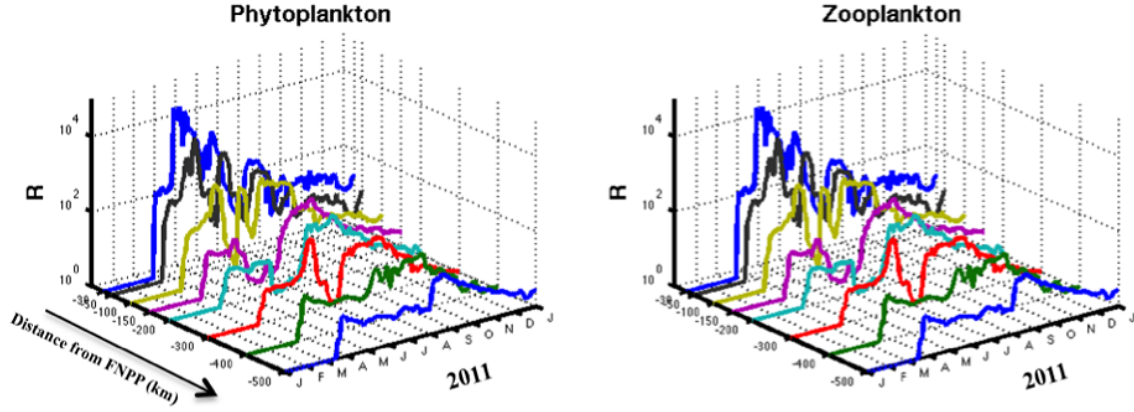
Figure 6. Calculated ratios ( R ) of 137 Cs concentration in phytoplankton and zooplankton in the accident situation to its concentration in the same population in the no-accident situation. The ratio was calculated for different sectors at various distances from